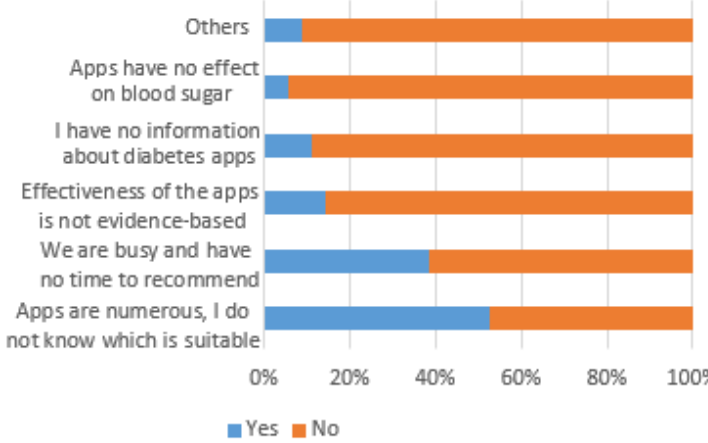
Figure 1. Factors influencing experts’recommendation of diabetes apps (n=127).